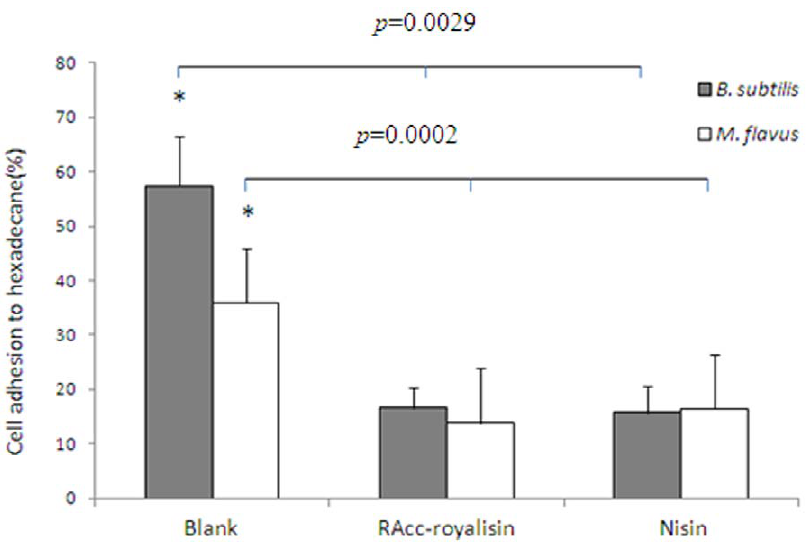
Figure 5. Determination of cell surface hydrophobicity as measured by cell adhesion.